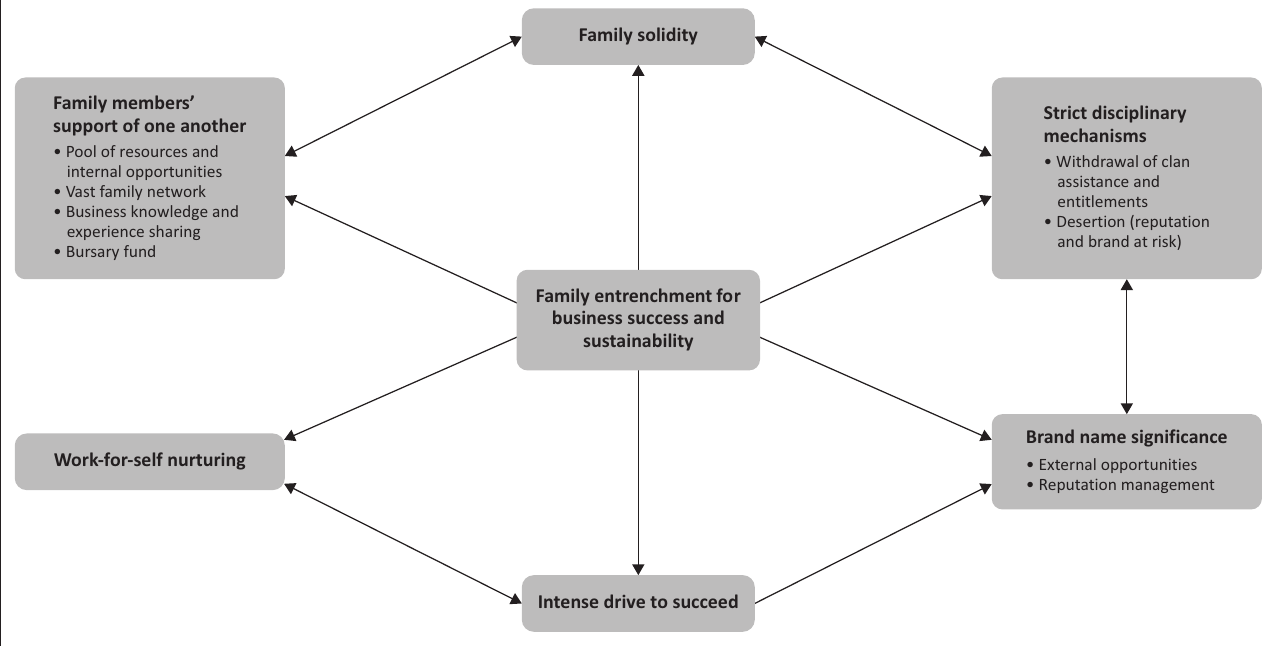
FIGURE 2: An illustration of the entanglement of family within the Maponya business case.